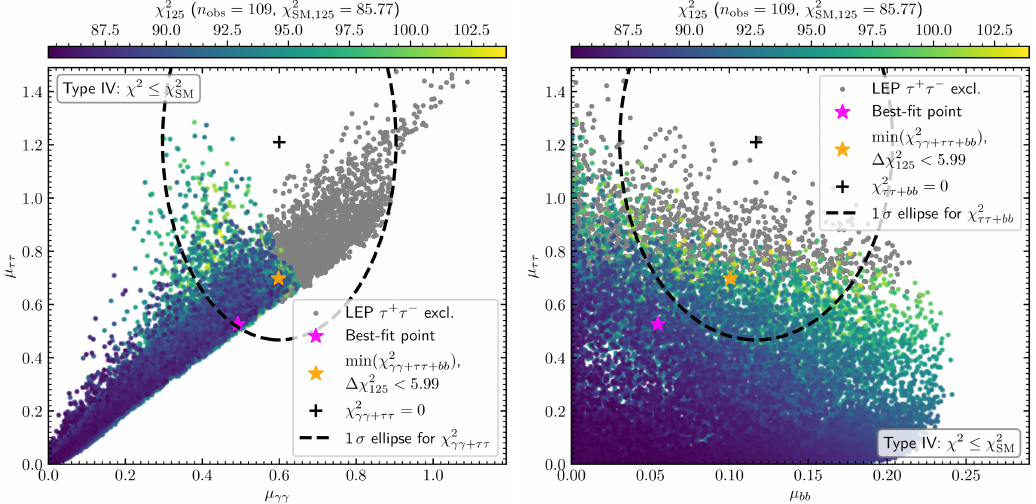
Figure 9 . As in figure 3, but those parameter points are shown in grey (plotted below the colored points) that would be excluded by the LEP limit in the τ + τ − final state if that channel had been selected in order to determine the 95% C.L.